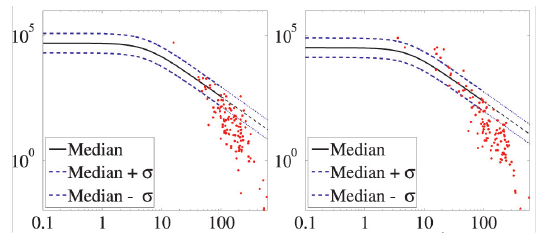
versus GMPEs, for the May 20 (left) and the May 29 (right), Figure 4. I A 2012, events. Horizontal axis: always R by r /(2 · g ) (cm 2 /s 3